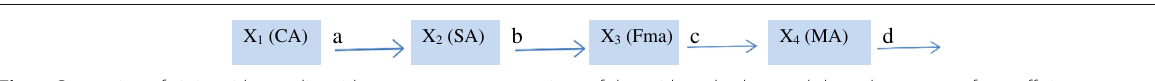
Fig. 4 Conversion of citric acid to malic acid. x i represent concentrations of the acids and a, b, c, and d are the rate transfer